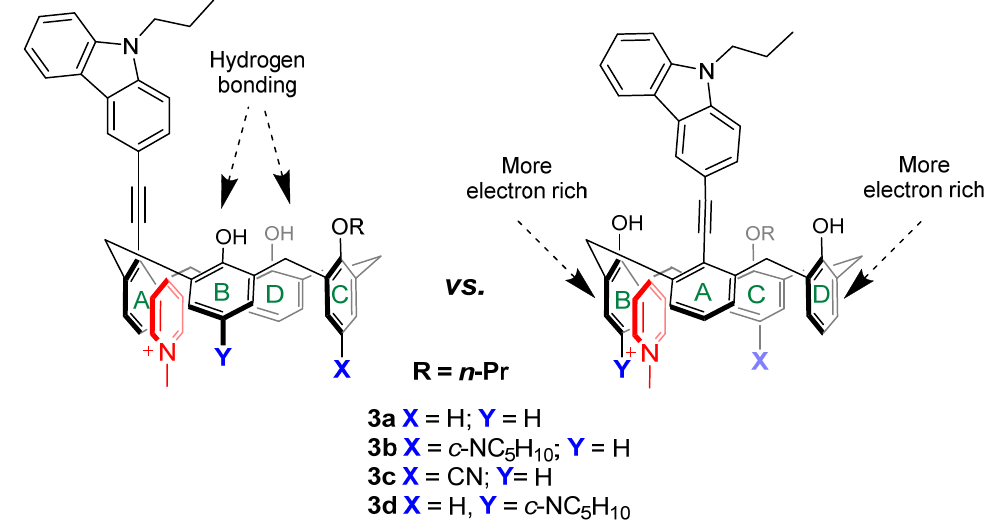
Figure 2. Proposed π interactions between 2 and carbazole-appended calixarenes 3 .